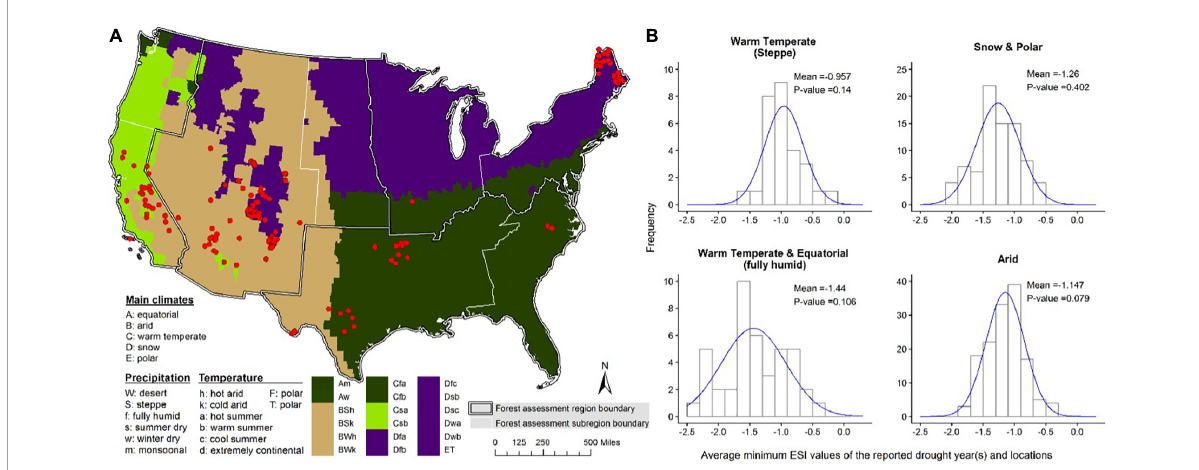
FIGURE2 Drought thresholds for identifying drought-associated disturbance in each climate zone of the CONUS. (A) Major climate zones in the CONUS made by modifying Koppen–Geiger climate classification map for the U.S. counties, among which the light green represents the Warm temperate (steppe) climate, light sienna for the Arid climate, purple for the Snow and Polar climate, and darkgreen for the Warm temperate (fully humid) climate. The red dots indicate the locations of the 292 drought-induced tree mortality events identified through literature survey. (B) Normality test results of the drought indices of Evaporative Stress Index (ESI) at the locations of drought-induced tree mortality events within each climate zone.